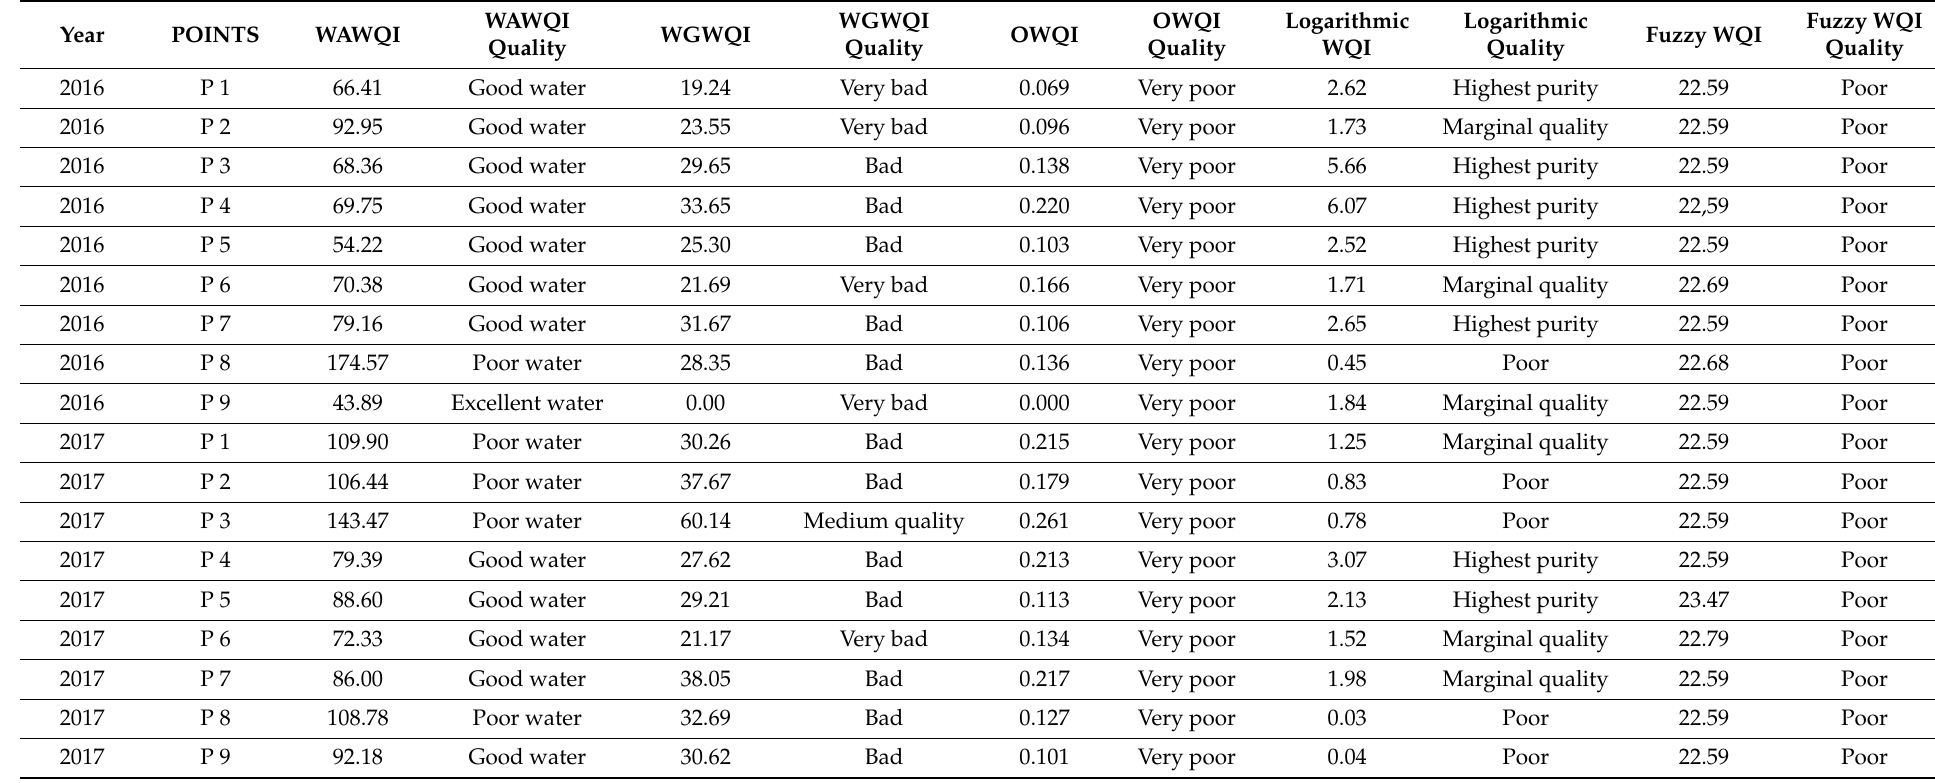
Table 10. Comparison between results of four WQIs and FL for nine wells in 2016 and